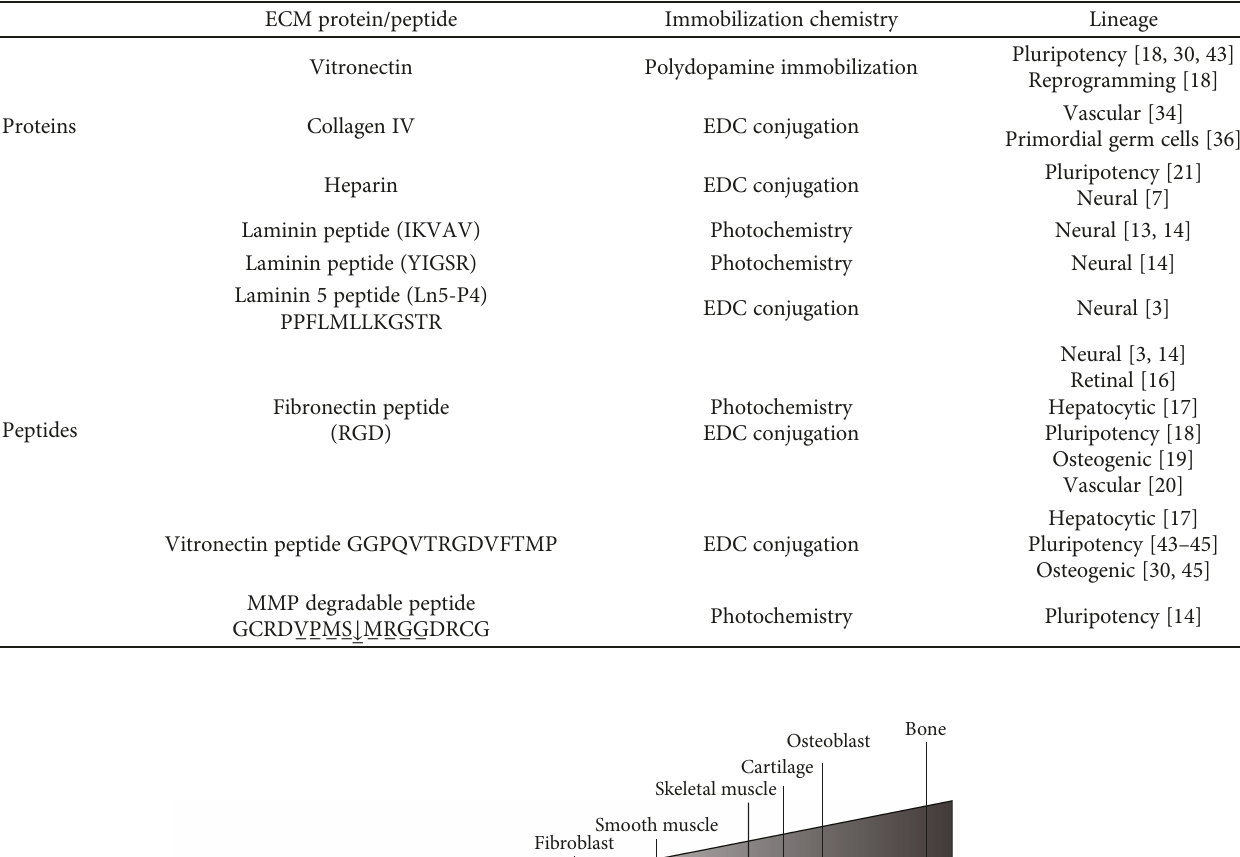
Table 2: ECM-derived proteins/peptides used within PSC culture systems to control cell fate.